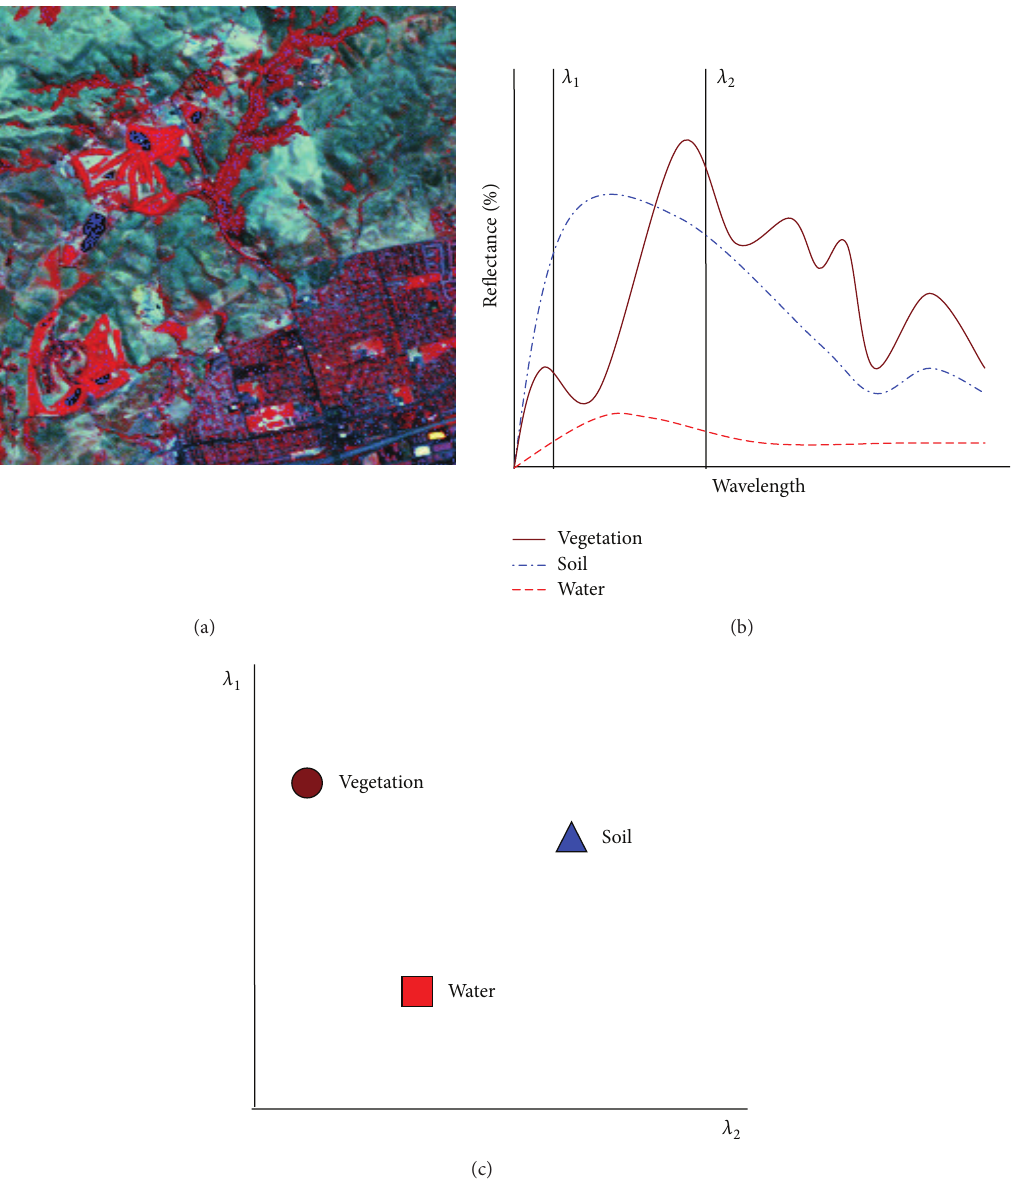
Figure1: Thedescriptionmodel ofhyperspectral image data. (a)Themodel oforiginal hyperspectral image. (b)Thespectralmodel of original image. (c) The ground feature model of original